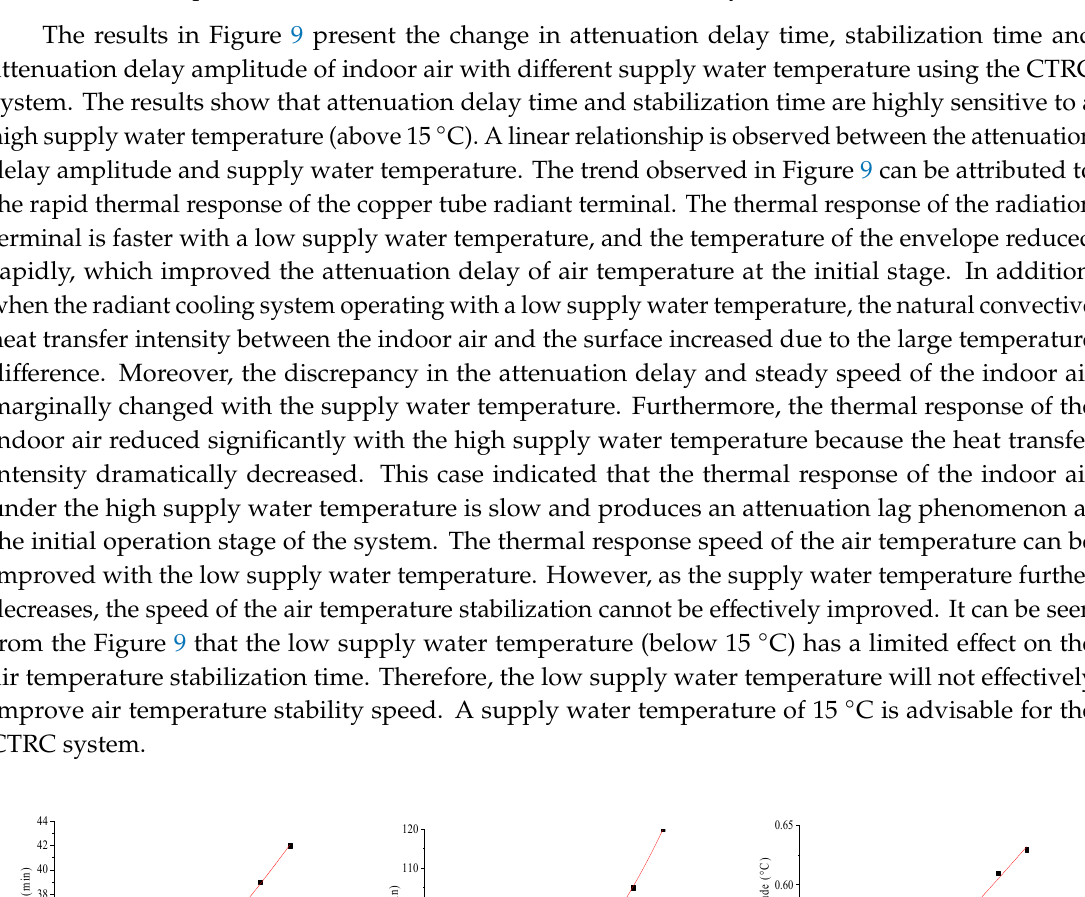
( c ) Figure 10. Change of attenuation delay time ( a ), stabilization time ( b ) and attenuation delay amplitude ( c ) of indoor air with different supply water temperature of CRC system. 4. Conclusions